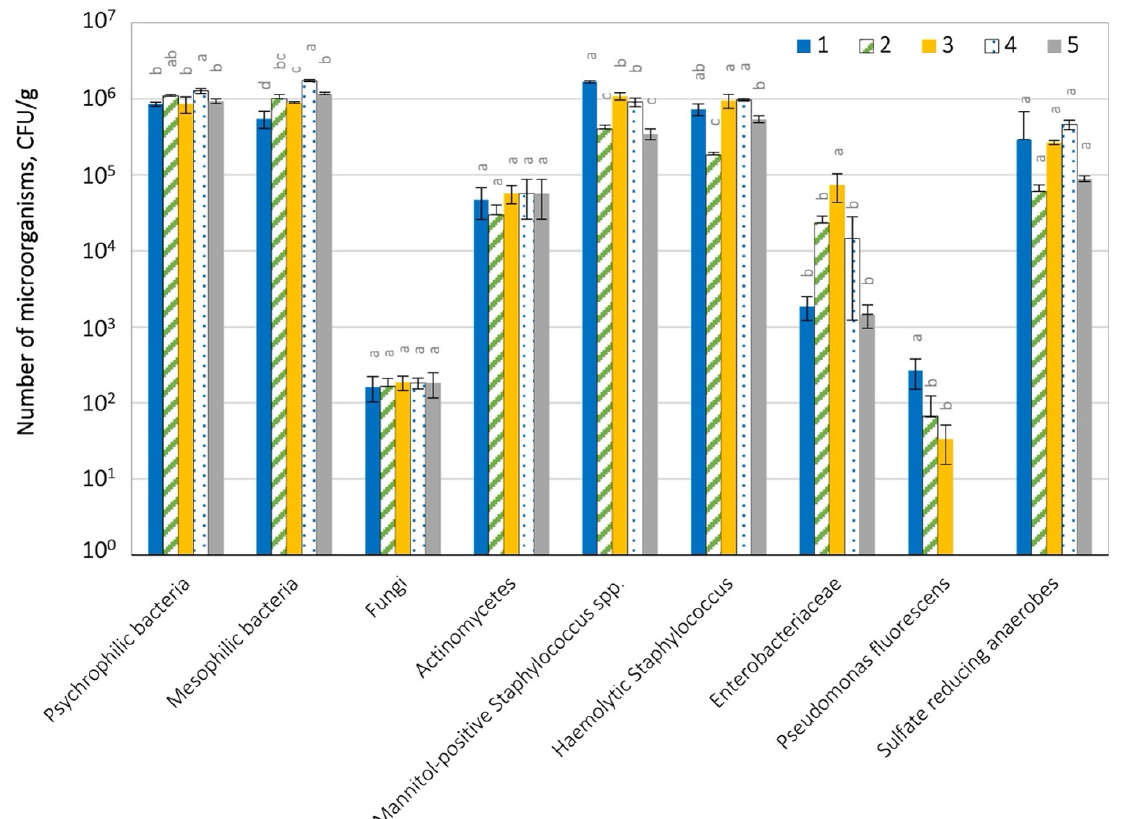
Figure 6. Microbiological contamination of soil in the tested landfill; 1–5 leachate sample numbers; statistically different samples within the same microorganism group were marked with different letters (Tukey’s test at p = 0.05).